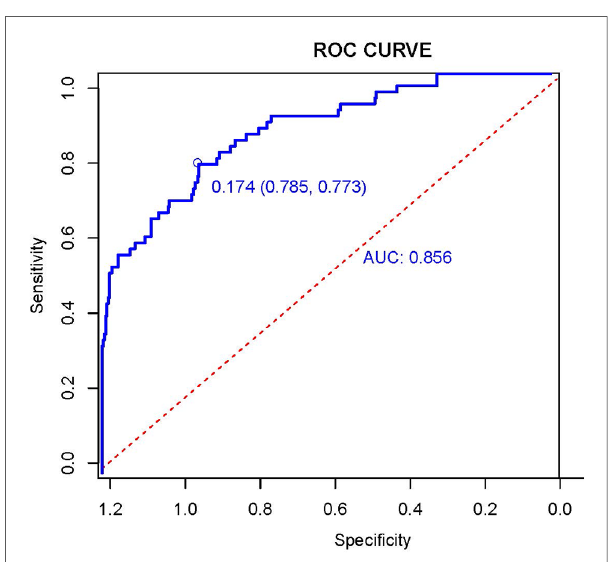
FIGURE 1 Receiver operation characteristic curve (AUC) of the logistic regression model. The AUC was used to test the performance of the prediction model.